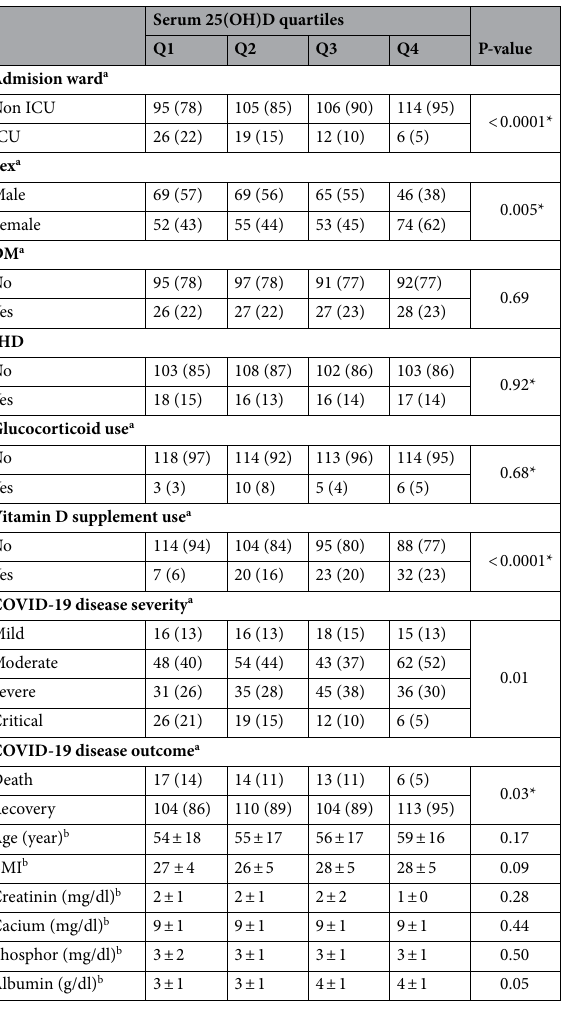
Table 3. The relationships of demographic and medical parameters across quartiles of serum 25(OH) D. DM diabetes mellitus, HTN hypertension, IHD ischemic heart disease, BMI body mass index. a n (%). b Mean ± SD. *Cochran-Armitage test for